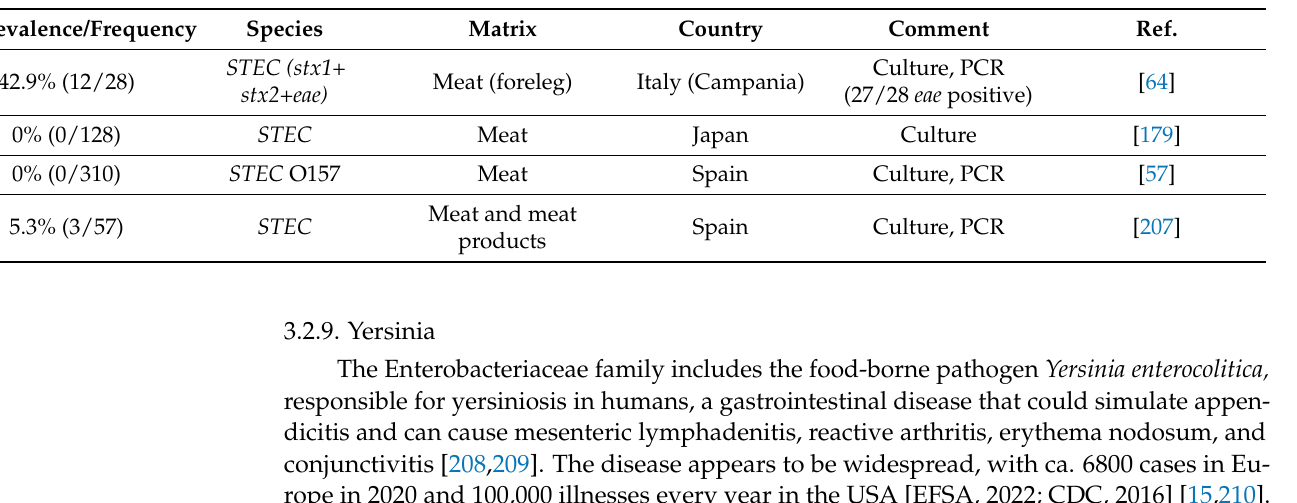
Table 13. Prevalence of Shiga toxin-forming E. coli in wild boar meat and